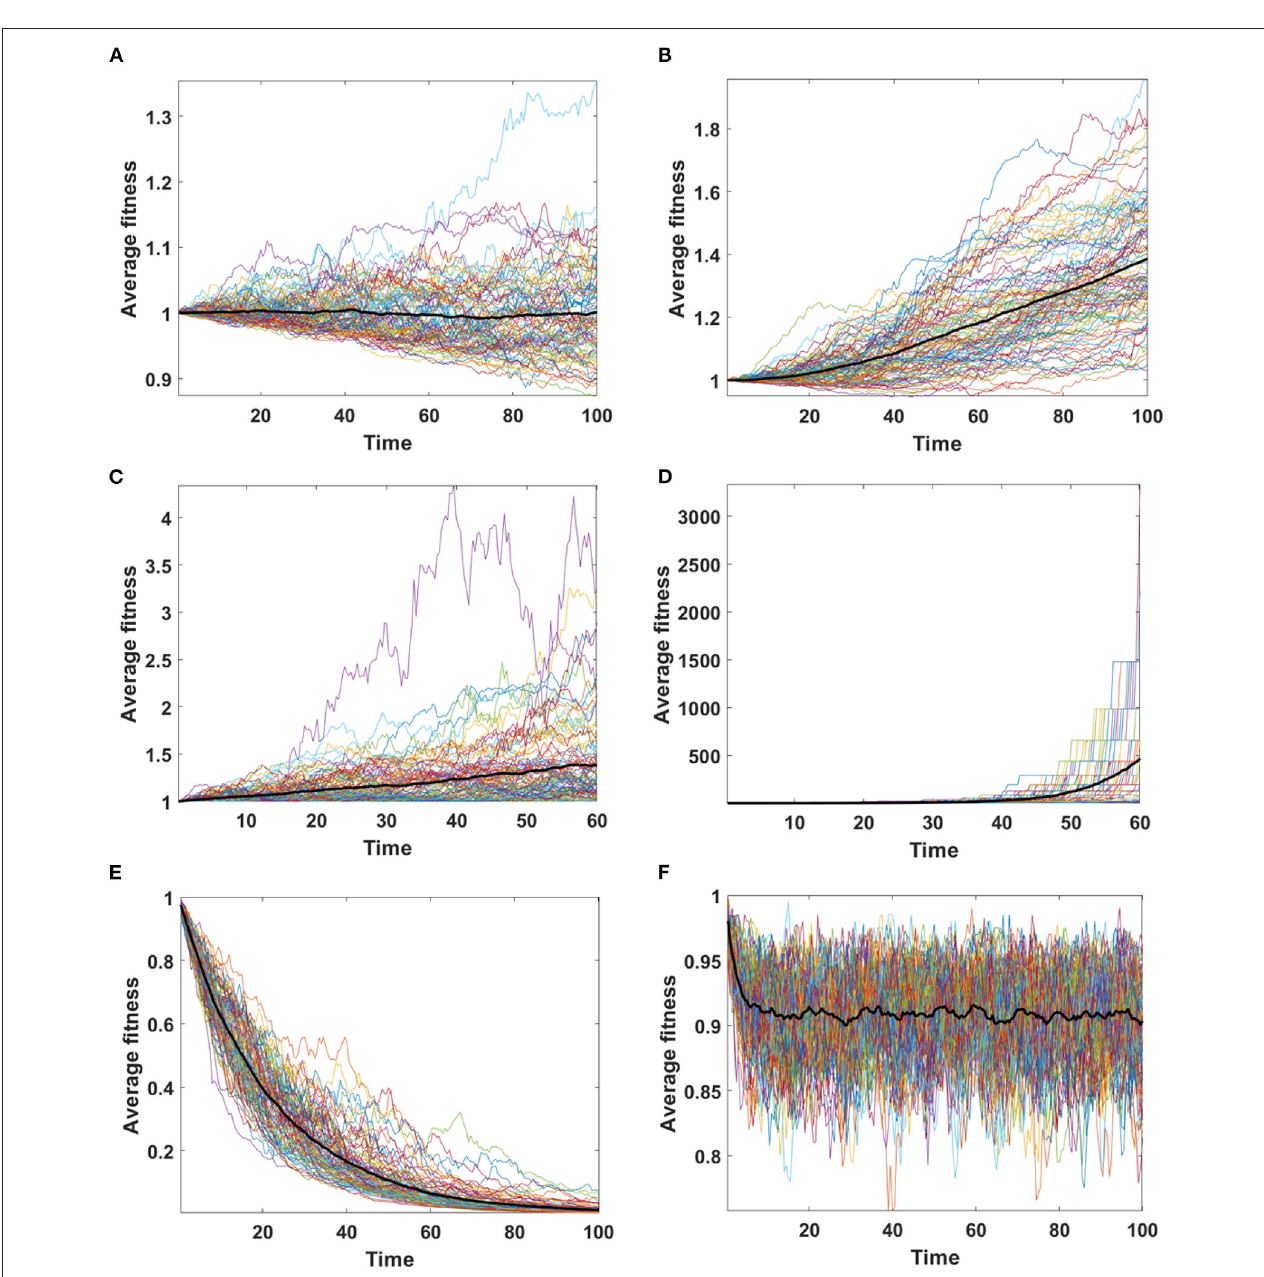
FIGURE 8 | Average fitness of cells as a function of time. Bold lines represent the mean of average fitnesses from 100 simulations. (A,B) Results for 100 simulations on N = 100 cells in equilibrium ( sp = dq ) with parameters: s = 0.1, d = 0.01, µ = 0.1, p = 0.0909. (A) Model A; (B) Model B. (C,D) Results for 100 simulations on N = 100 cells under selection ( sp ≫ dq ) with parameters: s = 0.5, d = 0, µ = 0.1, p = 0.1. (C) Model A; (D) Model B. Please note that the time range in plots C and D is 0 to 60, since some of the trajectories grow too fast to be accomodated by computer memory limits. (E,F) Results for 100 simulations on N = 100 cells under negative selection ( sp < dq ) with parameters: s = 0, d = 0.5, µ = 0.1, p = 0.1. (E) Model A; (F) Model B.